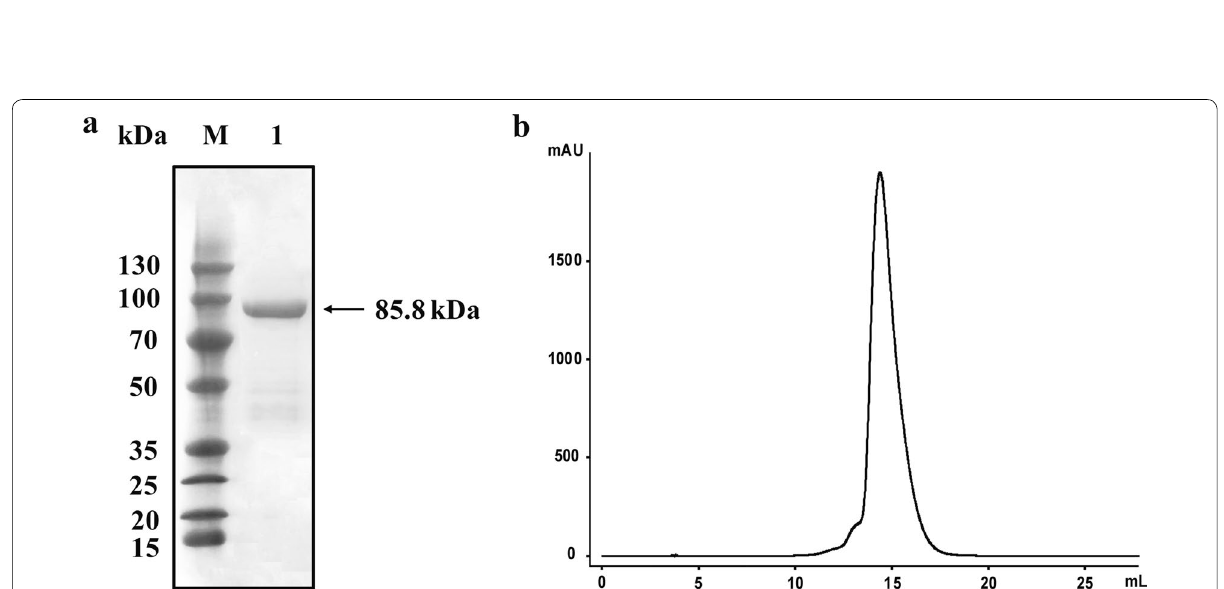
Fig. 2 Purification of the Mf Ago protein. a SDS-PAGE analysis of Ni–NTA-purified Mf Ago. M: protein marker; lane 1: purified Mf Ago. b Chromatograms of size-exclusion chromatography for Mf Ago. The measured UV absorbance (mAU) at 280 nm is shown against the elution volume